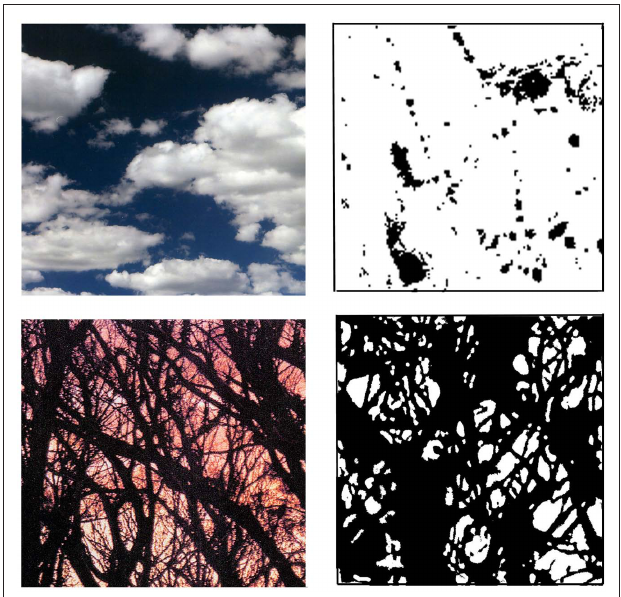
FiGurE 2 | Examples of natural scenery (left column) and poured paintings (right column). Top: Clouds and Pollock’s painting Untitled (1945) are fractal patterns with low D values ( D = 1.3 and 1.10 respectively). Bottom: A forest and Pollock’s painting Untitled (1950) are fractal patterns with high D values (both D = 1.89).